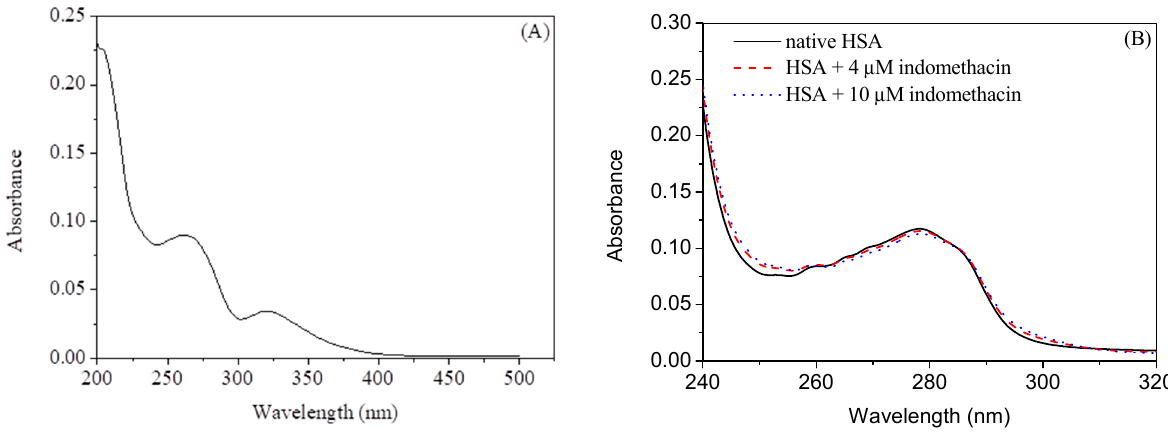
Figure 2. ( A ) UV absorption spectrum of 5 µ M indomethacin in 20 mM buffer of pH 7.4. ( B ) Difference UV absorption spectra of HSA in absence and presence of indomethacin at 25 ◦